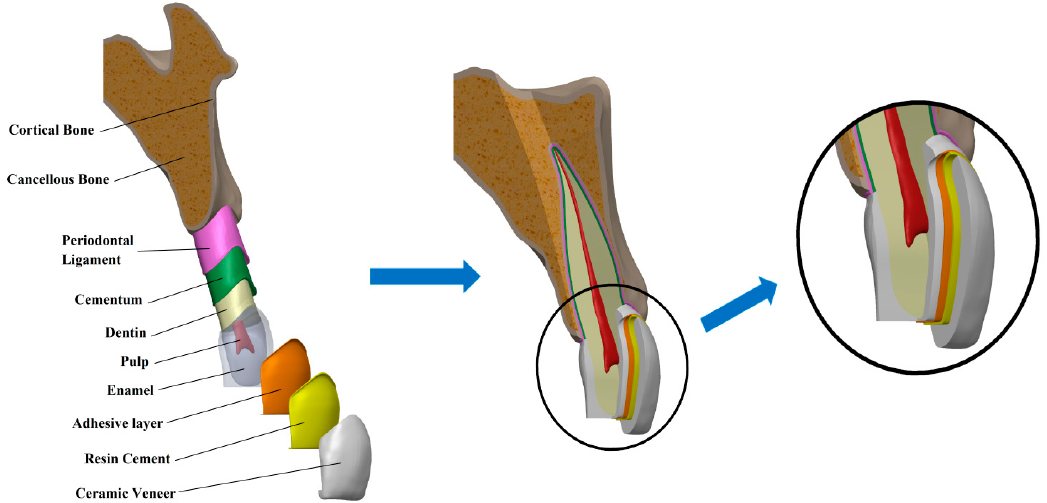
Figure 1. Exploded model and constructed geometry models of the maxillary central incisor with veneer restoration.